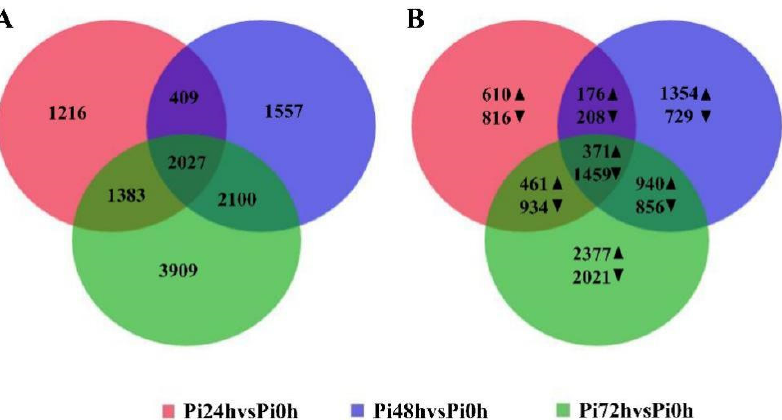
Figure 2. Venn diagram for comparison of DEGs at different infection time points. The red, green and